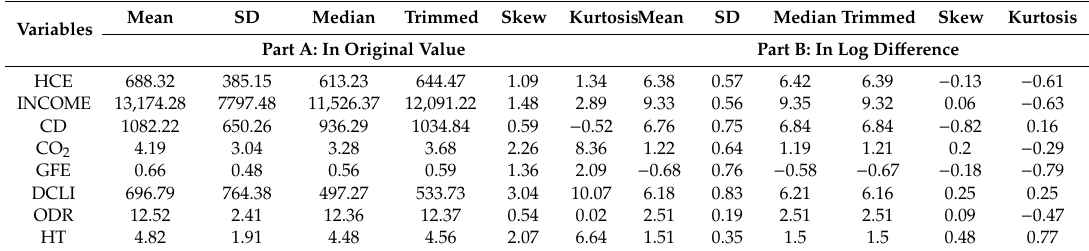
Table 3. Summary of statistics for all the variables.